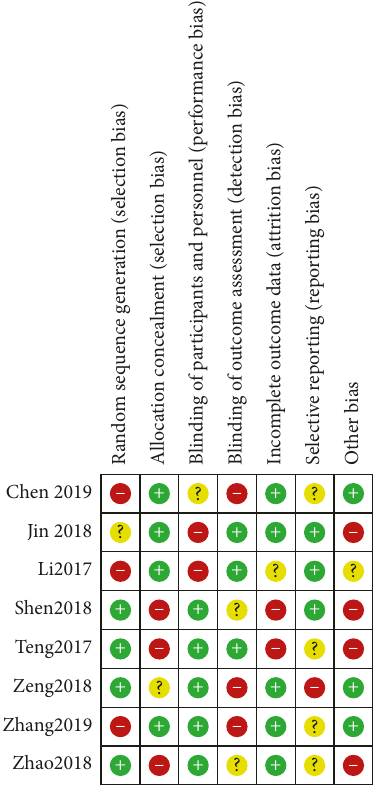
Figure 3: Summary chart of risk bias.